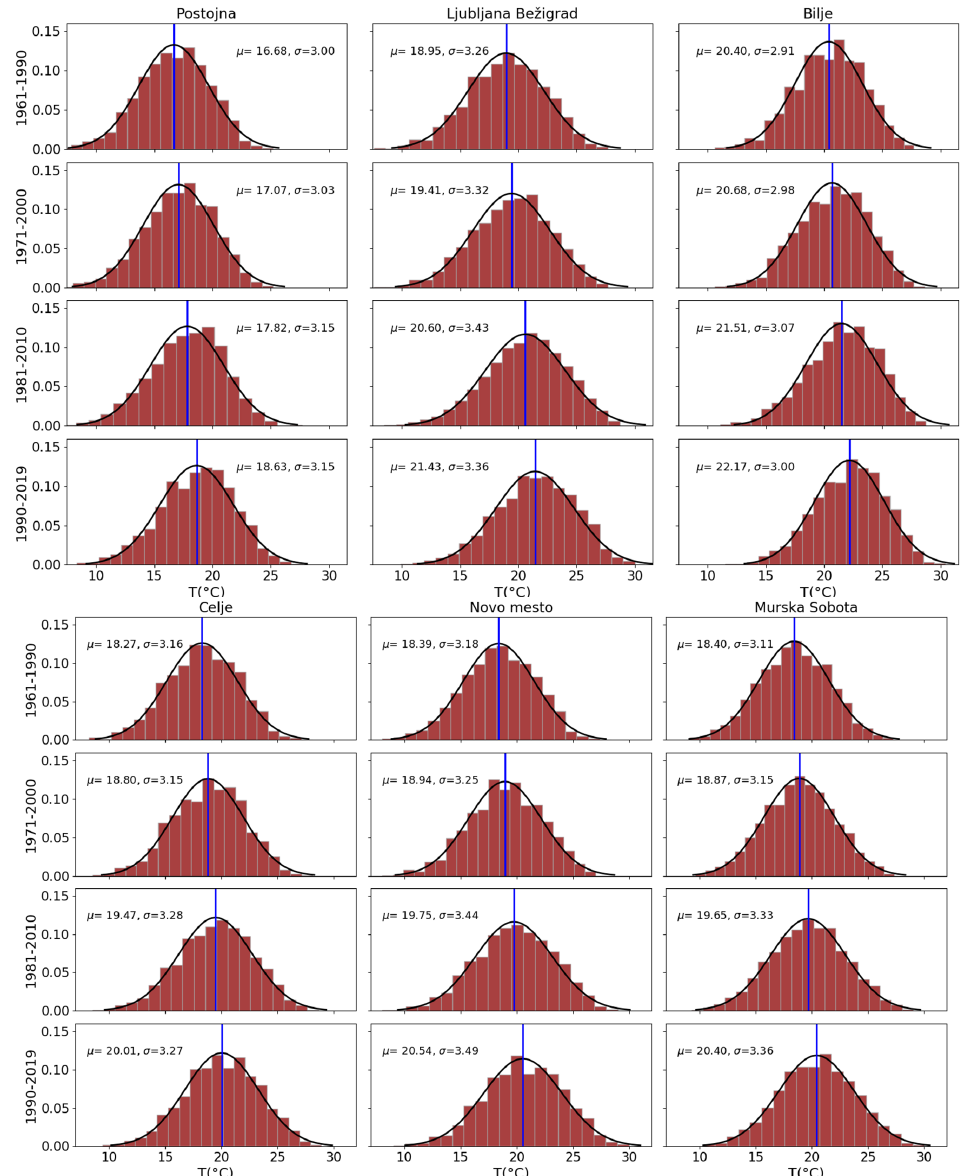
Figure 2. Distribution of summer (June‒August) daily average temperatures in four periods (Bilje from 1962) in six locations in Slovenia.